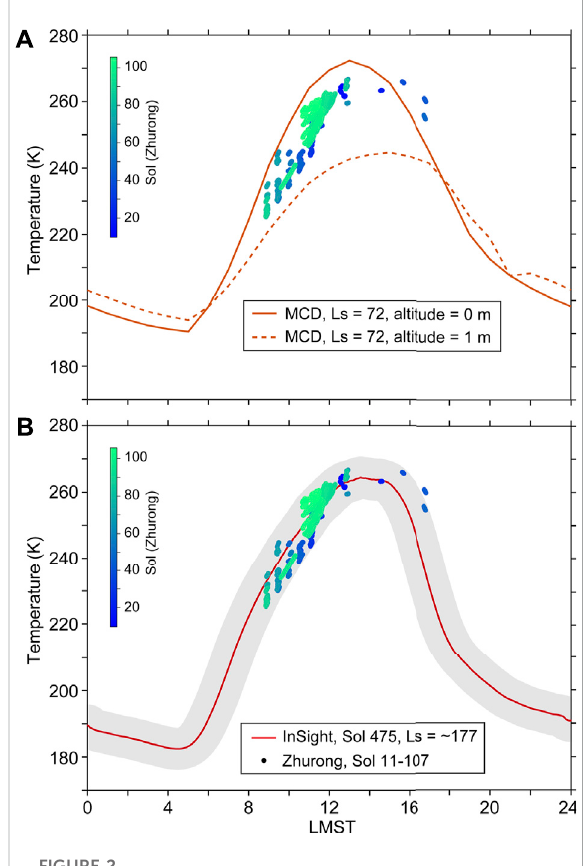
FIGURE 2 Temperature correction at the Zhurong landing site by InSight temperature observation. (A) Record data at the Zhurong landing site (~1 m over the ground) and MCD modeled temperature at Ls of 72 ° with altitudes of 0 m and 1 m, respectively. (B) Zhurong recorded temperature data, compared with the daily temperature records at the InSight landing site in its Sol 475, with Ls = ~177 ° . The gray bar indicates an error of ±8 K